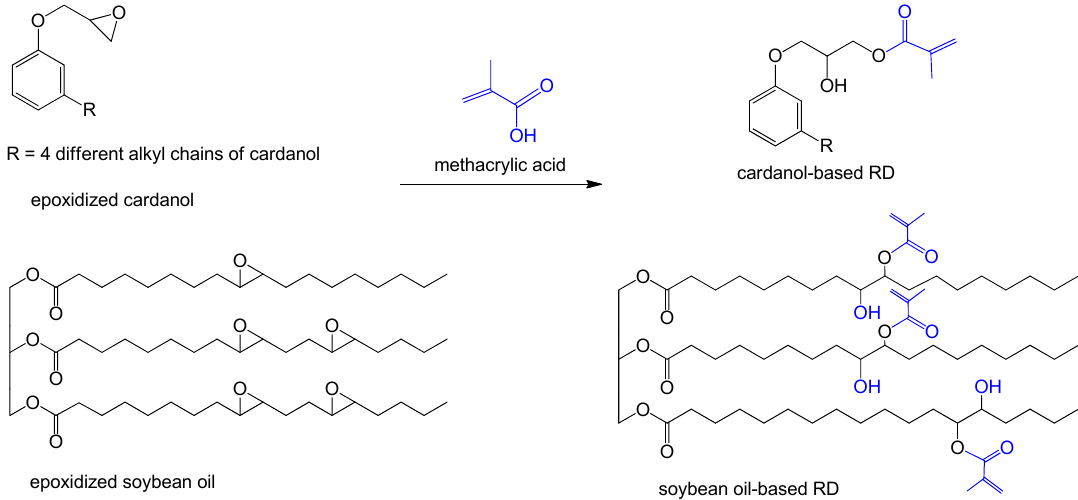
Figure 4. Synthesis of biobased methacrylates from epoxidized cardanol and soybean oil with methacrylic acid [48].